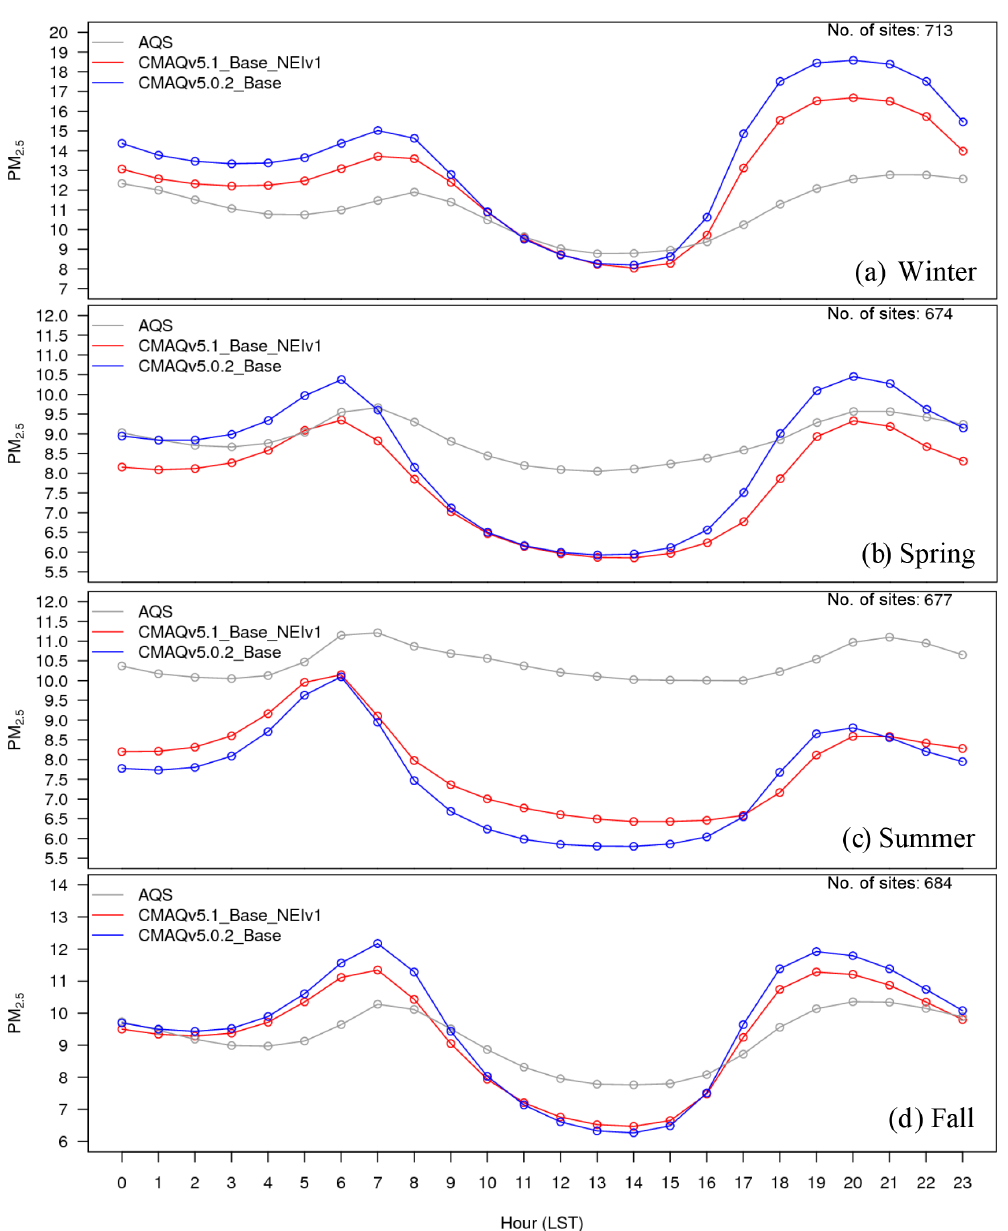
Figure 9. Diurnal time series of seasonal PM 2 . 5 (µgm − 3 ) for AQS observations (gray), CMAQv5.0.2_Base simulation (blue) and CMAQv5.1_Base_NEIv1 simulation (red) for (a) winter, (b) spring, (c) summer and (d)